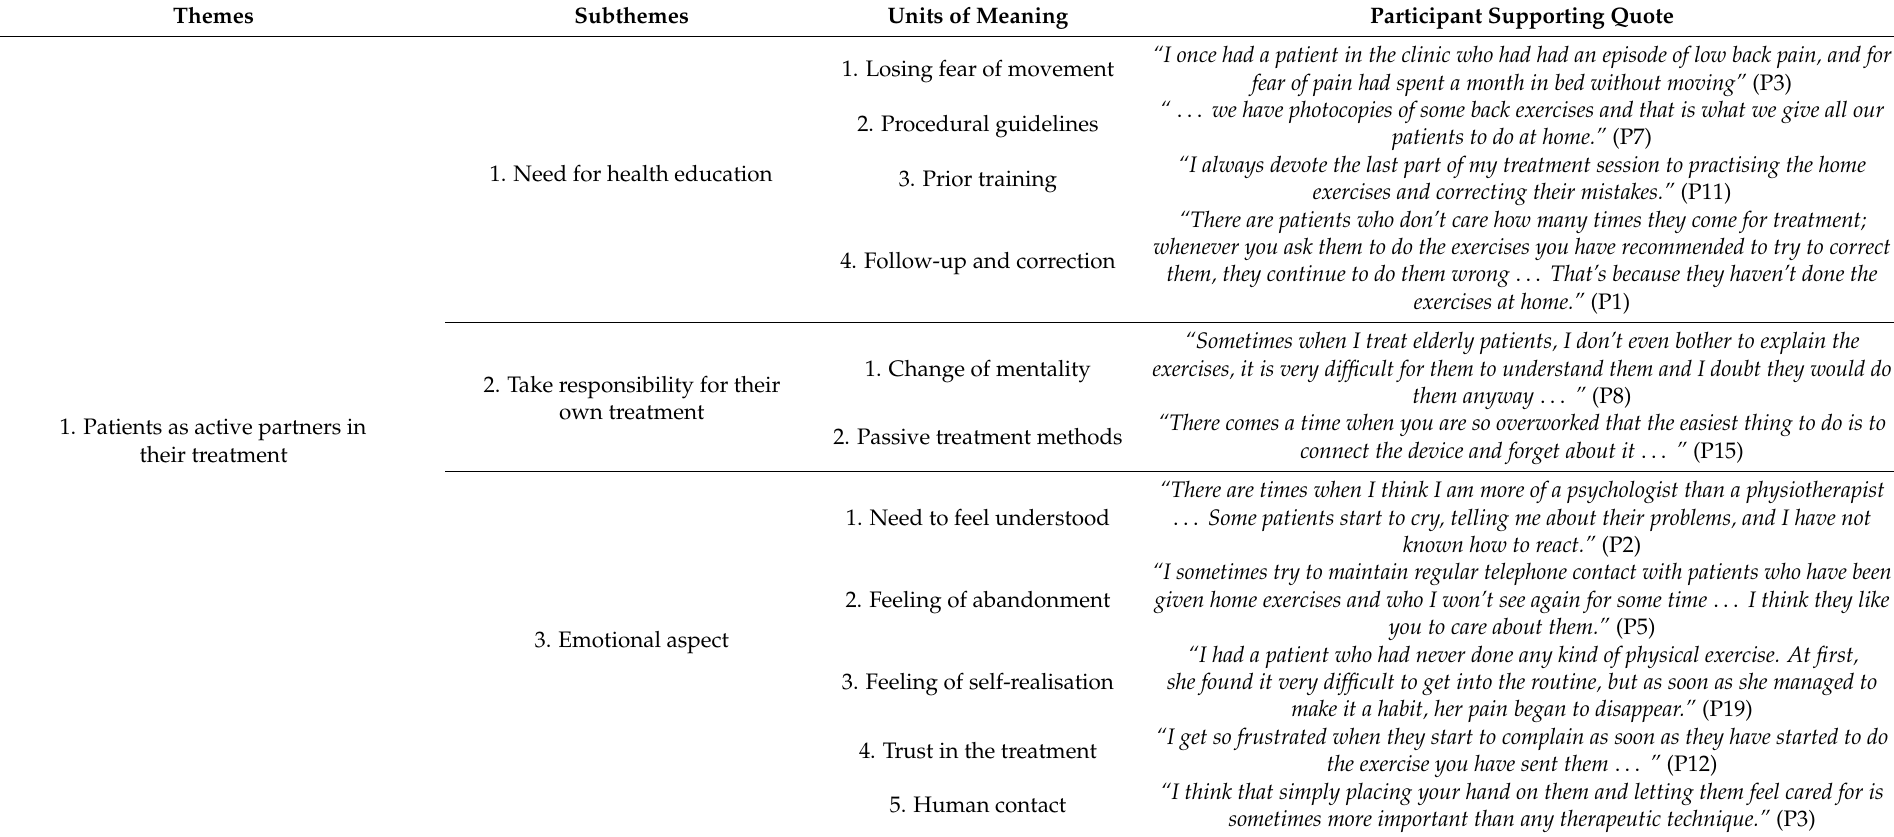
Table 2. Themes, subthemes and units of meaning with supporting quotes from the interviews participants (P =